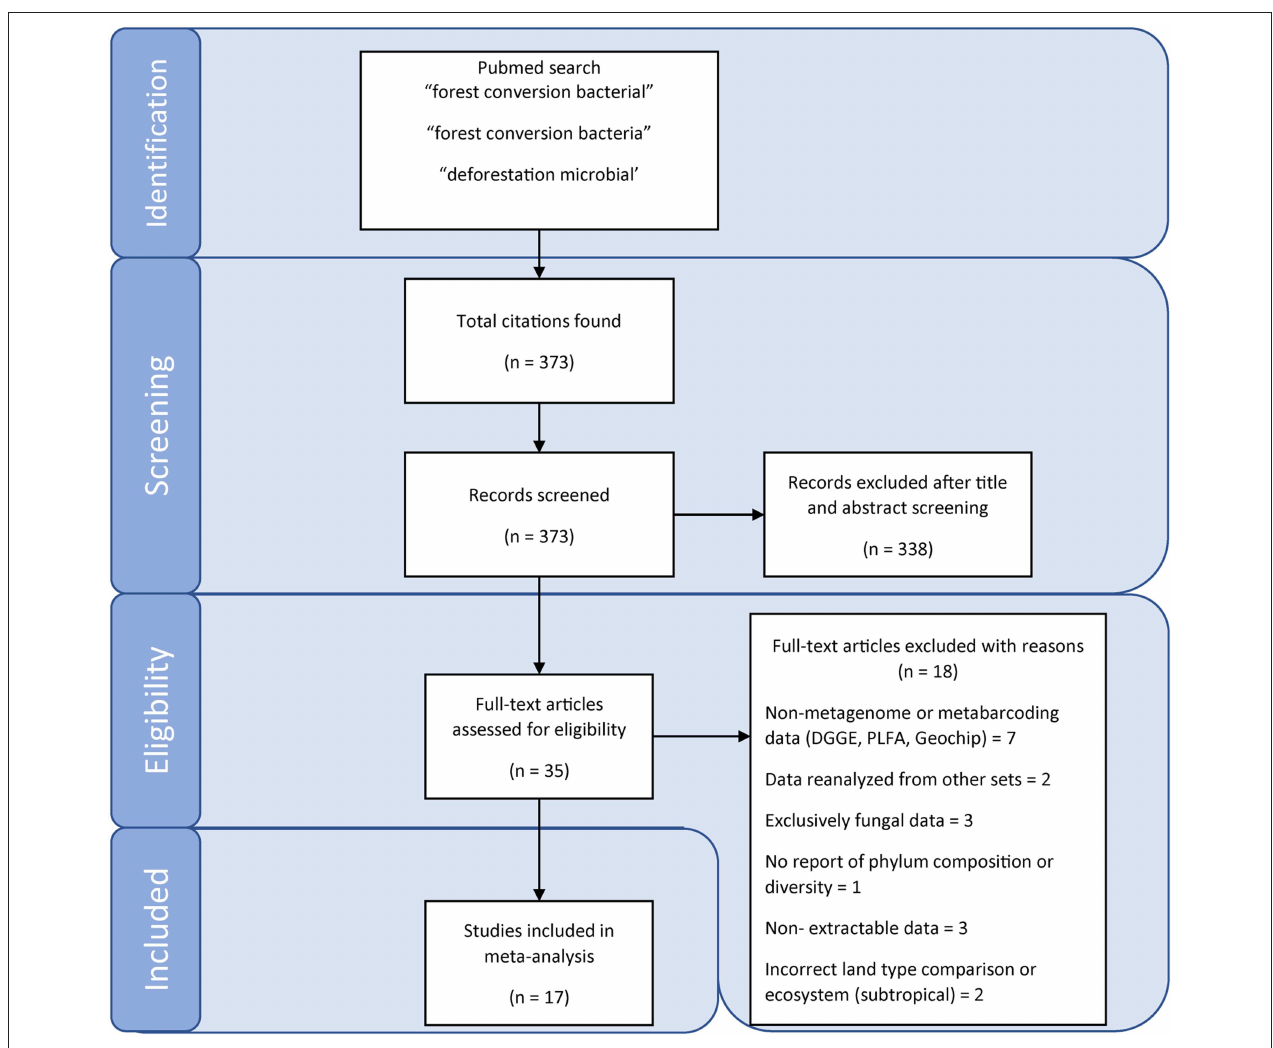
FIGURE 1 | Flow diagram for the selection of manuscripts.